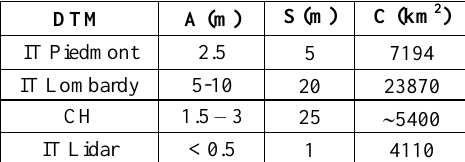
Table 1. The available data. A: nominal vertical accuracy. S: spatial resolution. C: covered area within the HELI-DEM region